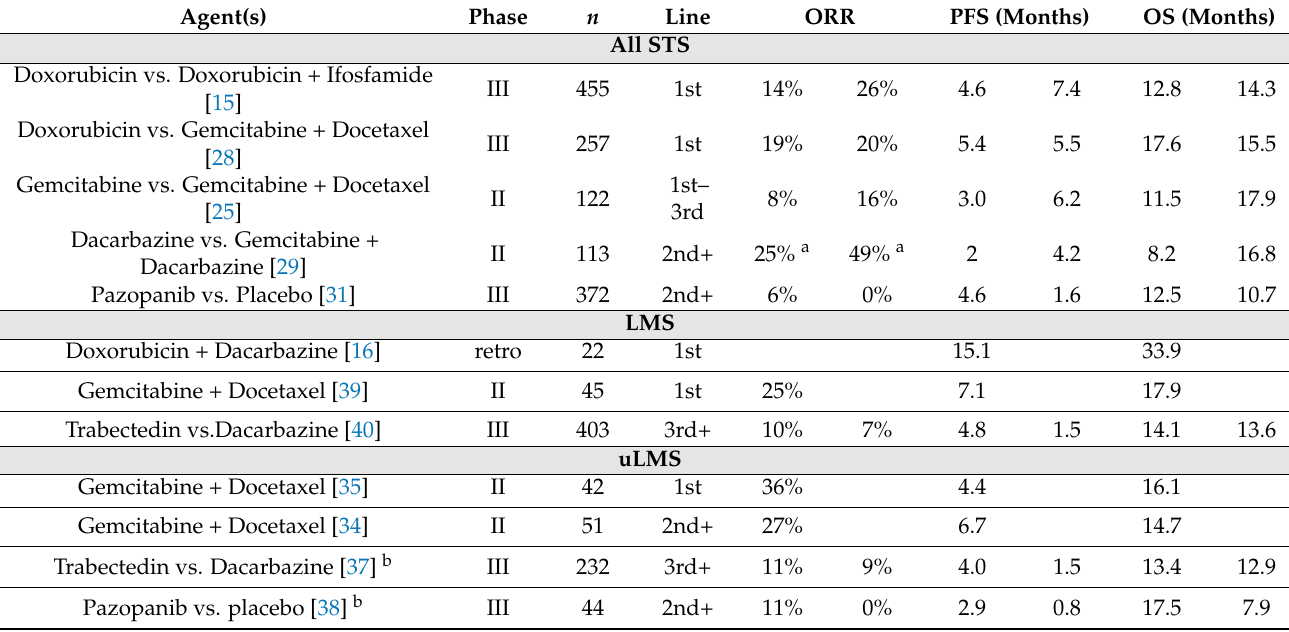
Table 1. Overview of key studies on current clinical management of advanced/metastatic uterine and extra-uterine patients with leiomyosarcomas (LMS) in the context of soft-tissue sarcoma (STS) therapy. Agent(s) Phase All